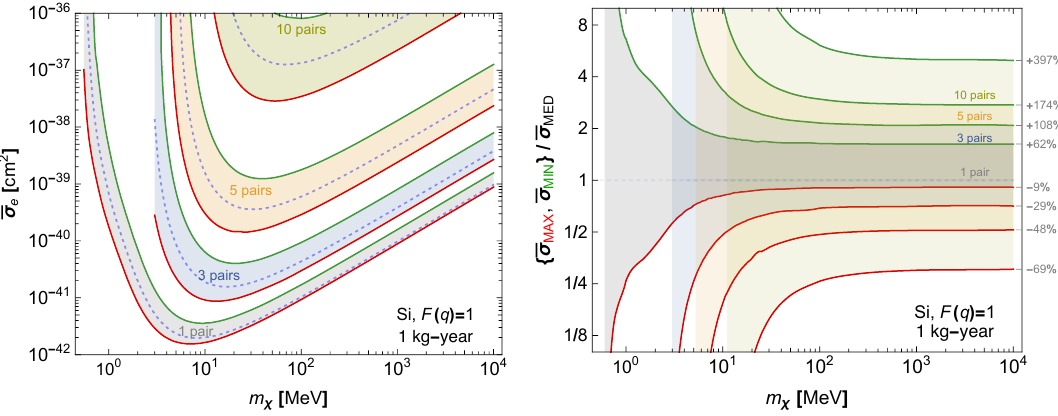
Figure 3 . The projected 95% C.L. sensitivities (left panel) and the size of the astrophysical uncertainty (right panel) for a silicon target with DM interaction described by the form factor F ( q ) = 1. The results are given for four di(cid:11)erent values of ionization threshold Q : 1 (gray), 3 (blue), 5 (orange) and 10 (light green) electron-hole pairs. In all cases the limiting solid lines correspond to the MIN (green) and MAX (red) velocity pro(cid:12)les, while the dotted lines show the central MED pro(cid:12)le. In all the cases the di(cid:11)erence in the local DM density is taken into account. In the right panel the size of the uncertainty is shown as the ratio of the MIN and MAX pro(cid:12)les to the MED pro(cid:12)le, and on the right hand side of the frame also as the percentage di(cid:11)erence from the best-(cid:12)t case.